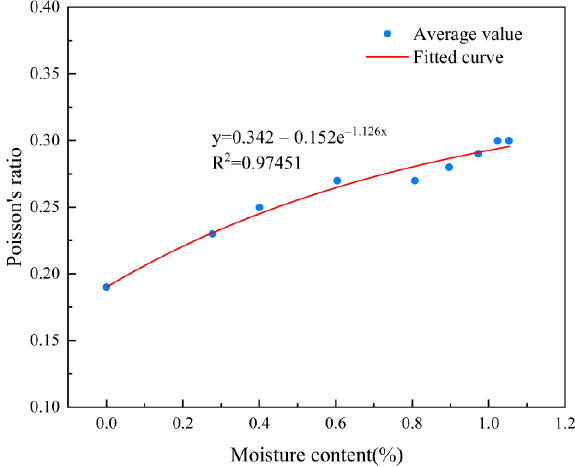
Figure 7. Relationship between Poisson’s ratio and moisture content.